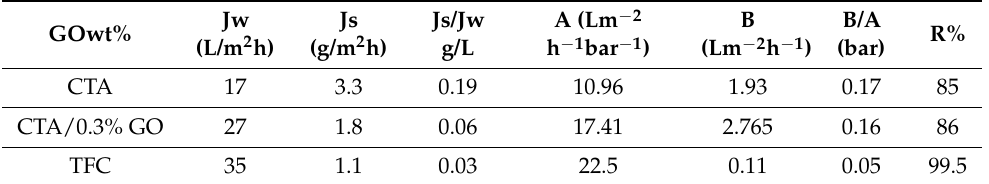
Table 3. Permeation properties of fabricated